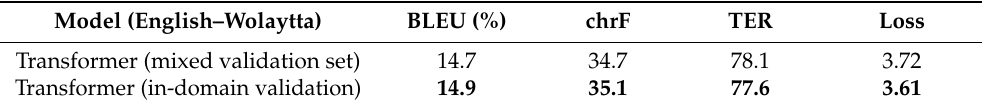
Table 6. BLEU, chrF, and TER scores of NMT models trained on the combination of synthetic and authentic datasets for Wolaytta–English translation.